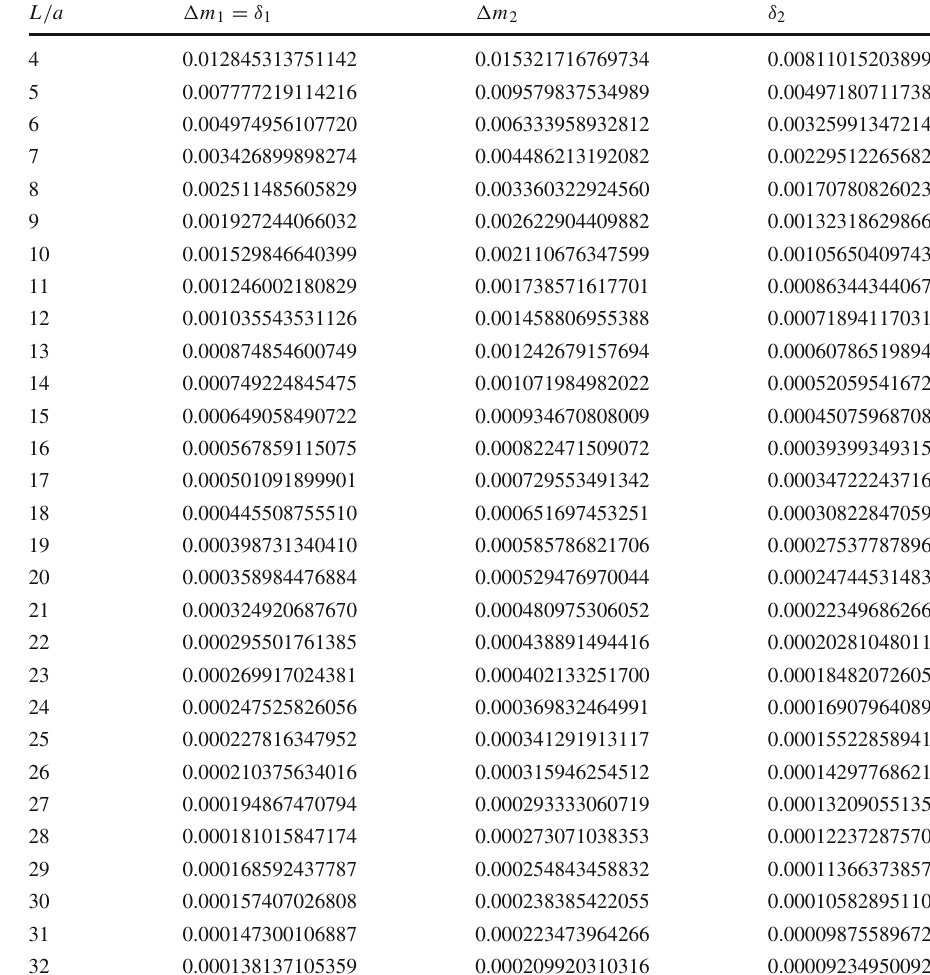
Table 8 Two-loop cutoff effects